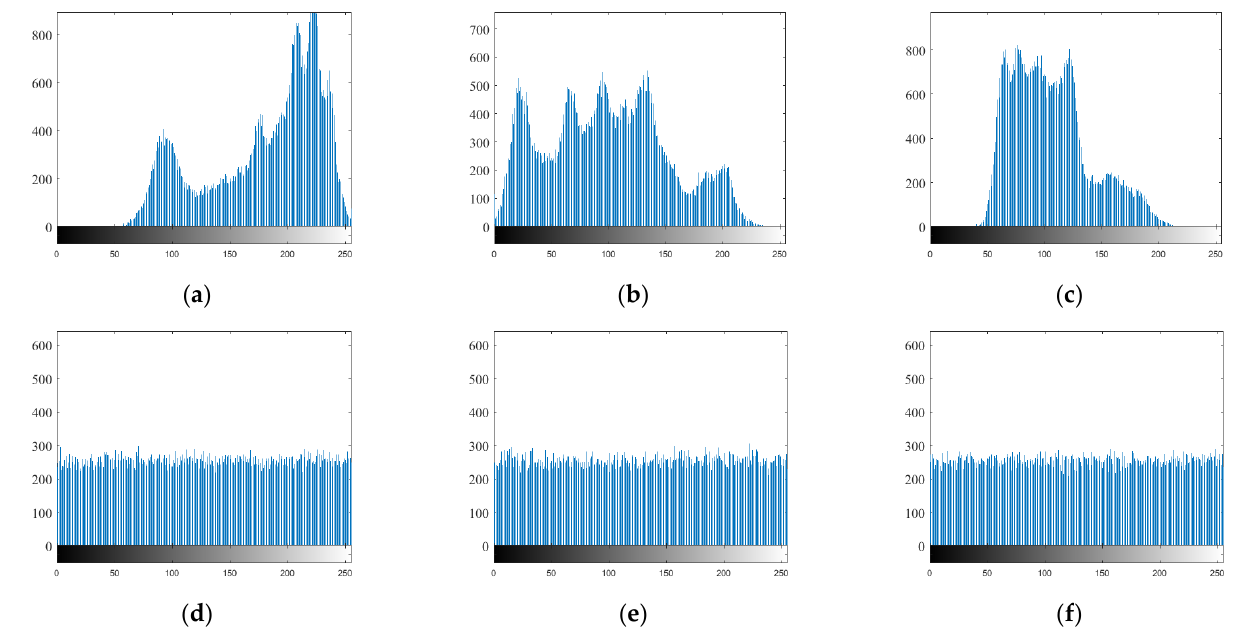
Figure 11. Histogram, ( a – c ) Histogram of plaintext, ( d – f ) Histogram of